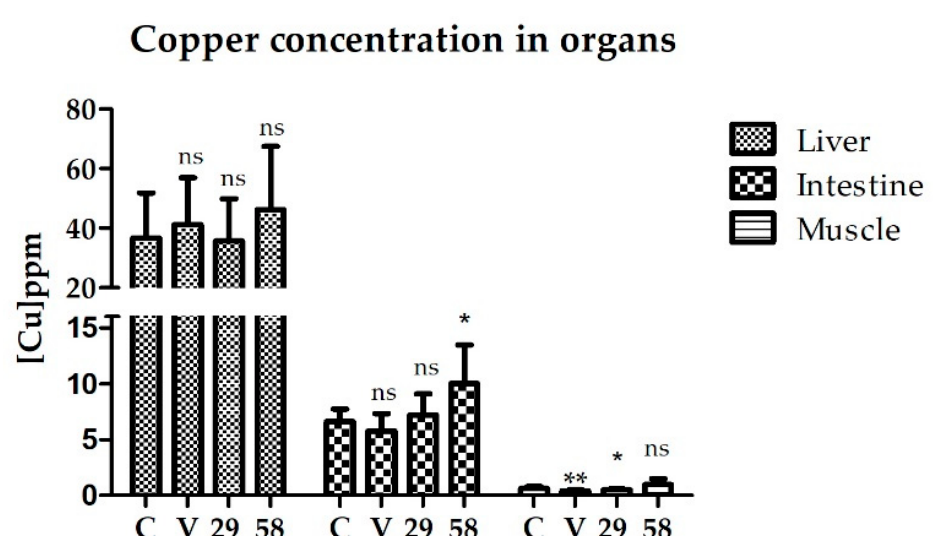
Figure 3. Copper concentration determined in the liver, intestine, and muscle of rainbow trout after 15 days of feeding with [Cu(NN 1 ) 2 ](ClO 4 ). C = control, V = vehicle control, 29 = concentration 29 µg/g of fish, and 58 = concentration 58 µg/g of fish. Statistically significant differences were determined in respect to the control by a one-way non-parametric t -test (Mann–Whitney) (* p < 0.05, ** p < 0.01)y, ns = not significant.